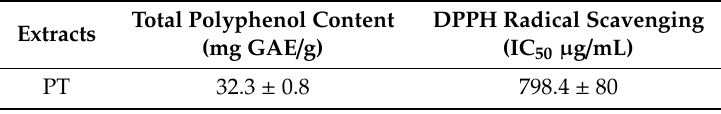
Table 2. Antioxidant capacities of PT extracts measured by total polyphenol content and DPPH radical scavenging assays.